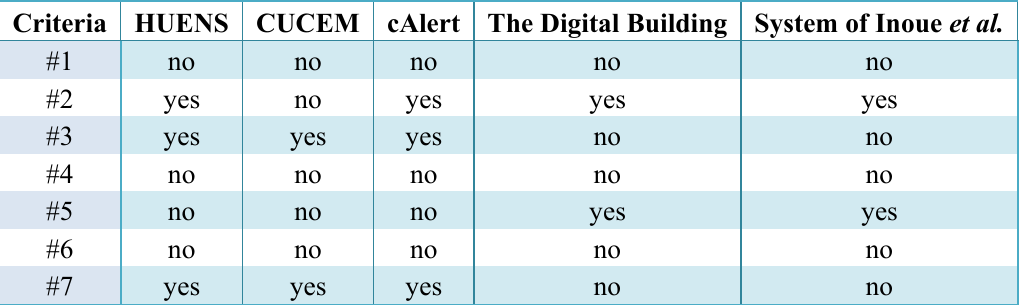
Table 2. Analysis of the State-Of-The-Art Systems with our Defined Set of Criteria.